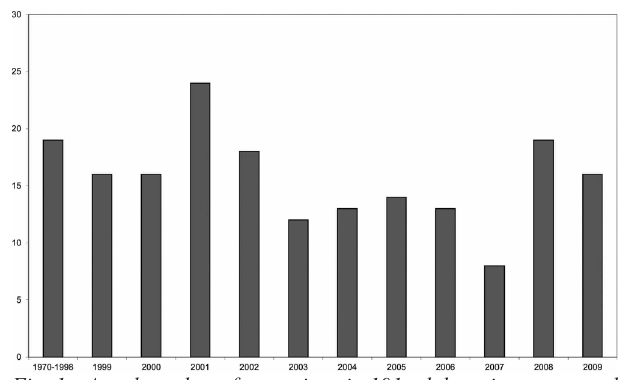
Fig. 1 - Anual number of operations in 191 adult patients operated on for congenital heart disease